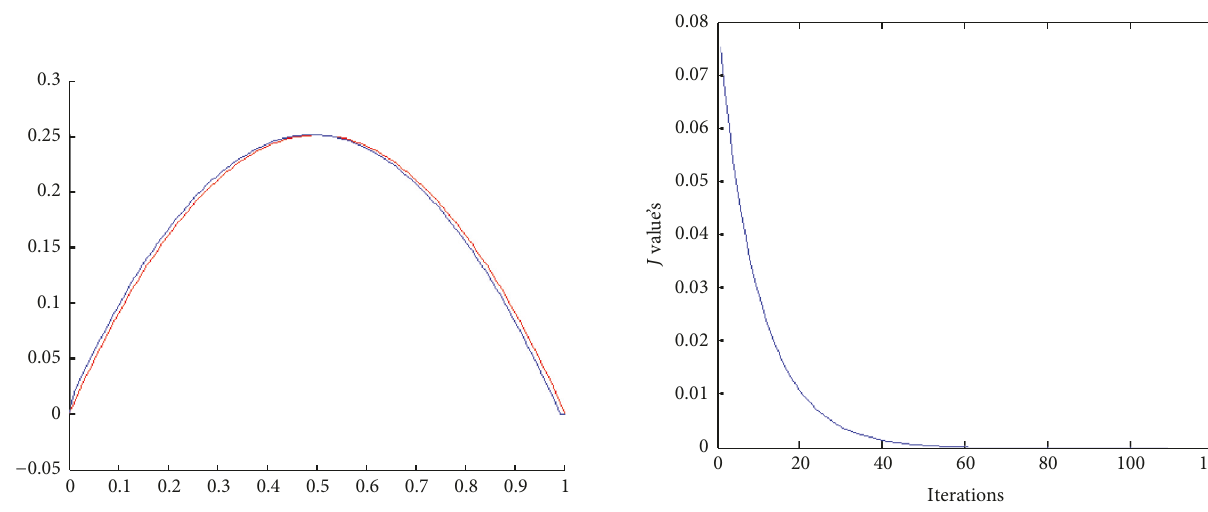
Figure 11: Graph of 𝐽 .